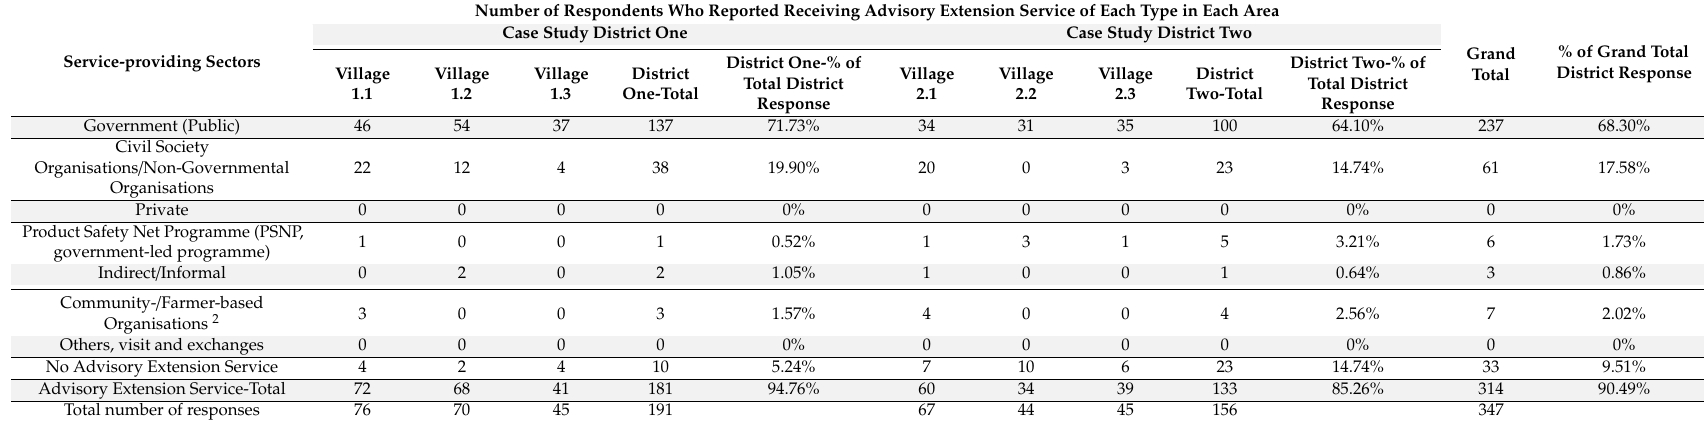
Table 2. Types of Advisory Extension Service received 1 by Smallholder Farmers (Questionnaire Survey). Responses categorised by Case Study